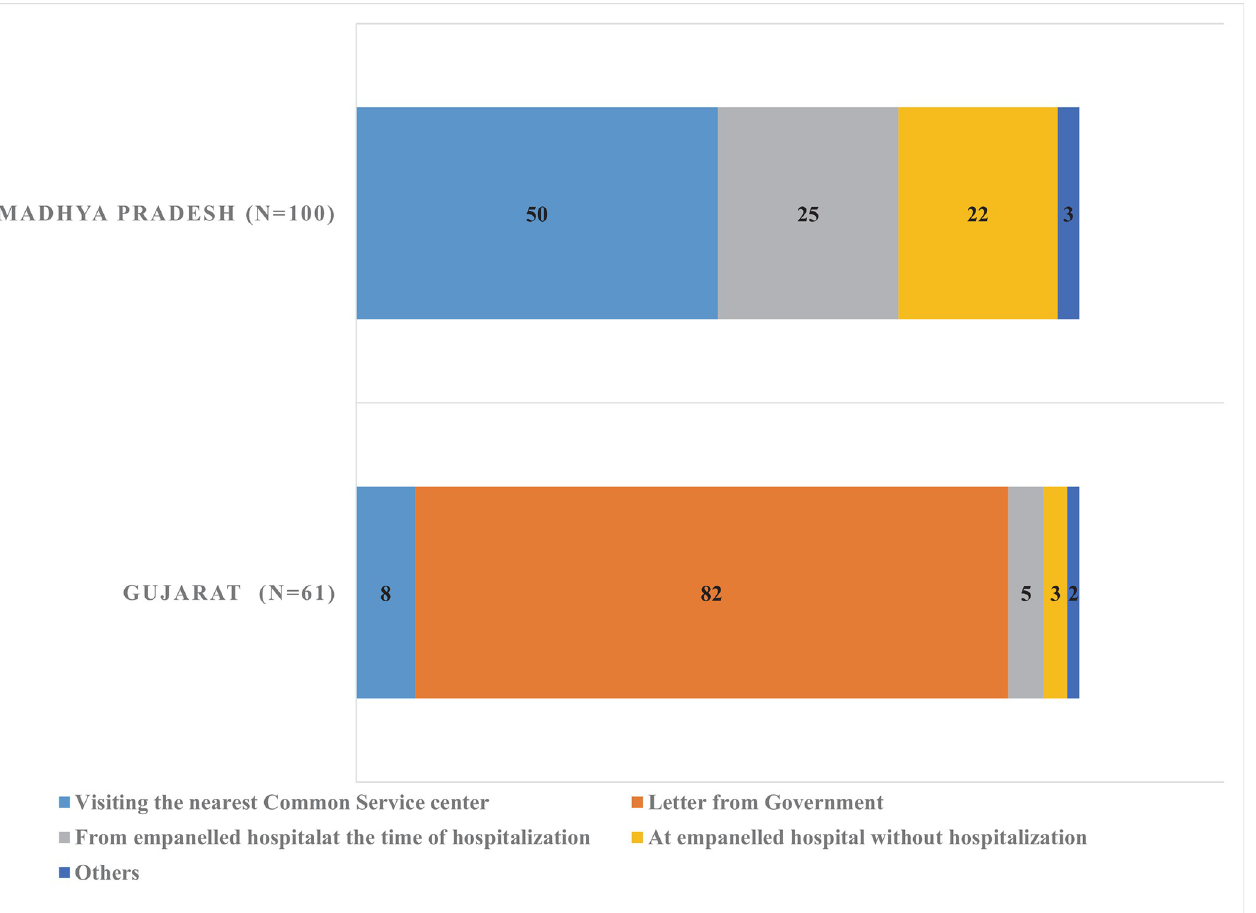
Fig 1. Proportion of beneficiaries by the source of eligibility checking: A comparison across states (In %).